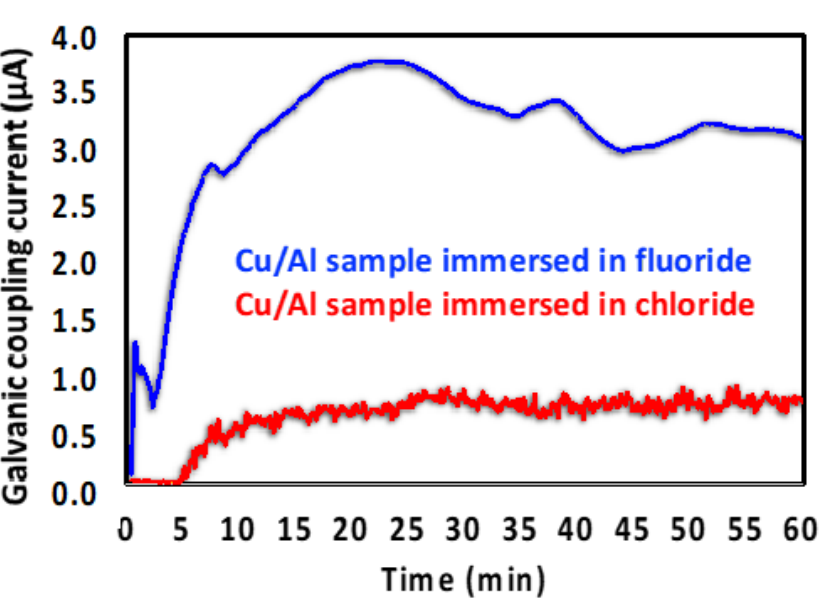
Figure 5. Galvanic coupling current for Cu-Al couple immersed in 5 ppm Cl − and 5 ppm F − solutions at pH 5.